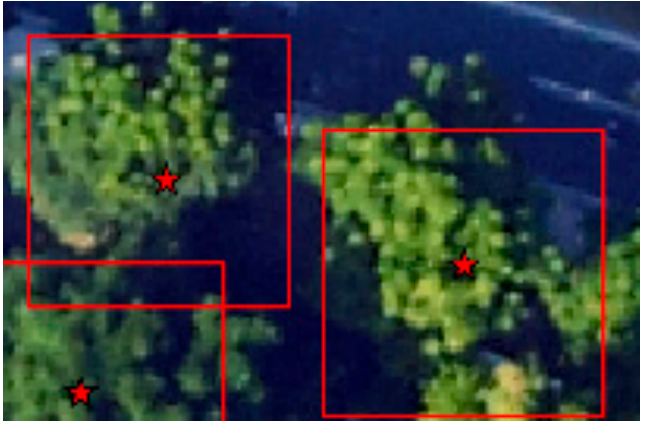
Figure 3. The RGB image was cropped into patches (red squares) based on the detected tree locations (red stars) with a patch size of 64 × 64 pixels each.